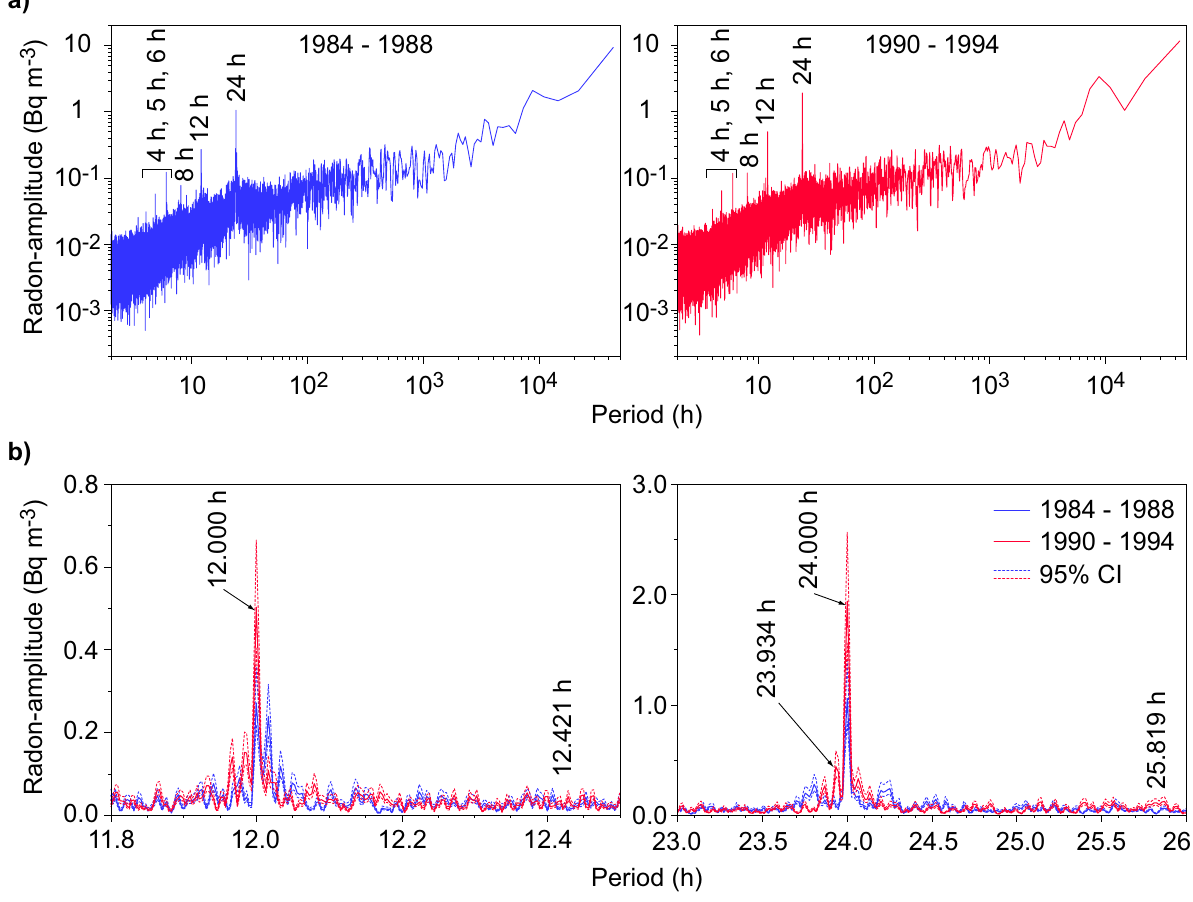
Figure 3. Amplitude spectra for hourly time series in atmospheric radon concentration. The 1984–1988 dataset and 1990–1994 dataset were analysed separately. ( a ) Amplitude spectra for whole periods. ( b ) Amplitude spectra around the periods of 12 h (left panel) and 24 h (right